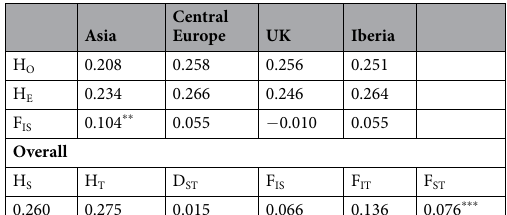
Central Europe UK